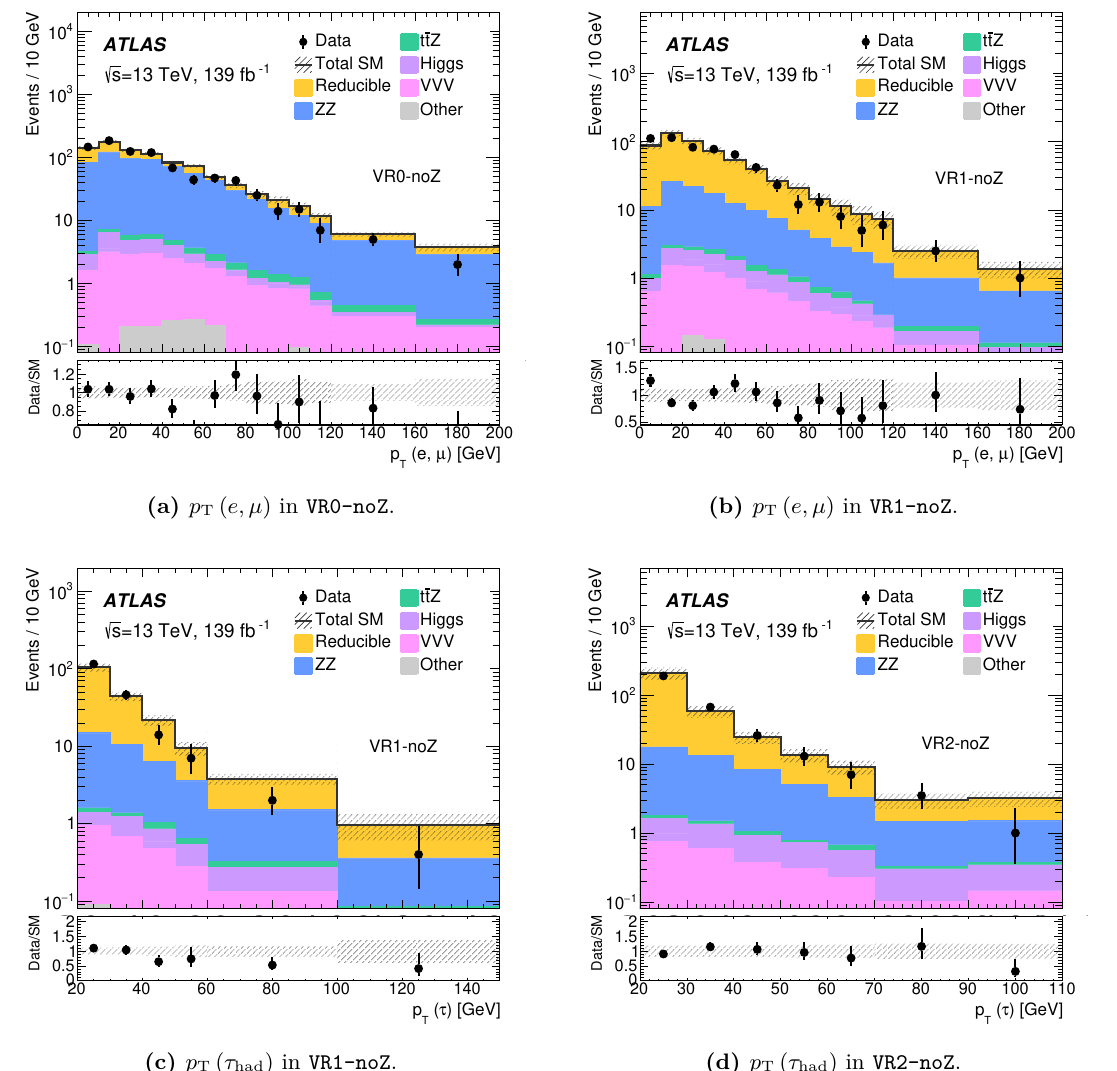
(c) p T ( τ had ) in VR1-noZ . Figure 6. The distributions for data and the estimated SM backgrounds in the validation regions after the background-only fit, for the light lepton p in (a) VR0-noZ and (b) VR1-noZ , and the τ T had p T in (c) VR1-noZ and (d) VR2-noZ . “Other” is the sum of the tWZ , t ¯ tWW , t ¯ tZZ , t ¯ tWZ , t ¯ tWH , t ¯ tHH , t ¯ ttW , and t ¯ tt ¯ t backgrounds. The last bin includes the overflow. The lower panel shows the ratio of the observed data to the expected SM background yield in each bin. Both the statistical and systematic uncertainties in the SM background are included in the shaded